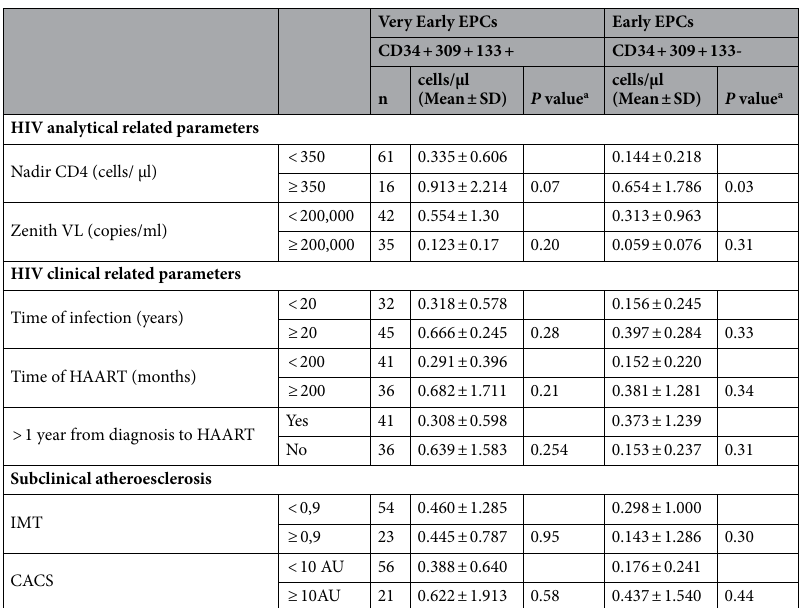
Table 4. Clinical and analytical factors associated with EPCs in patients with HIV infection and the relationship with subclinical atherosclerosis. EPCs endothelial progenitor cells, VL viral load dl, HAART highly active antiretroviral therapy, SD standard deviation, IMT intima media thickness, CACs coronary artery calcium score. a Two-tailed one-way ANOVA test.